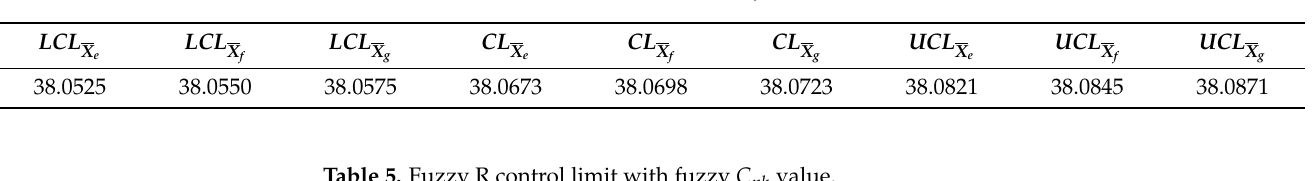
Table 4. Fuzzy X control limit with fuzzy C pk value.